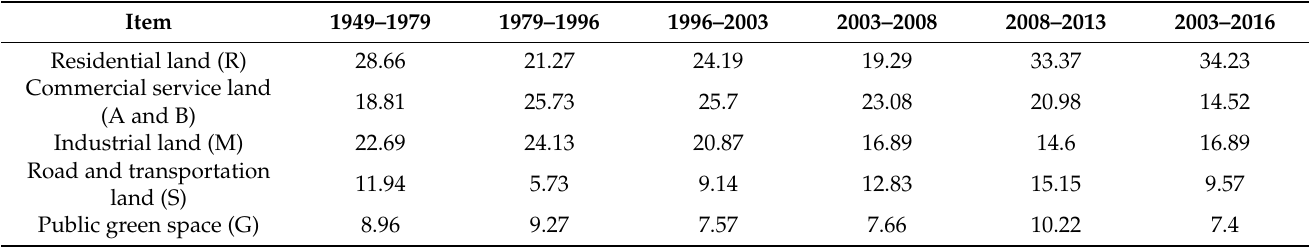
Table 2. Urban sprawl intensity 1